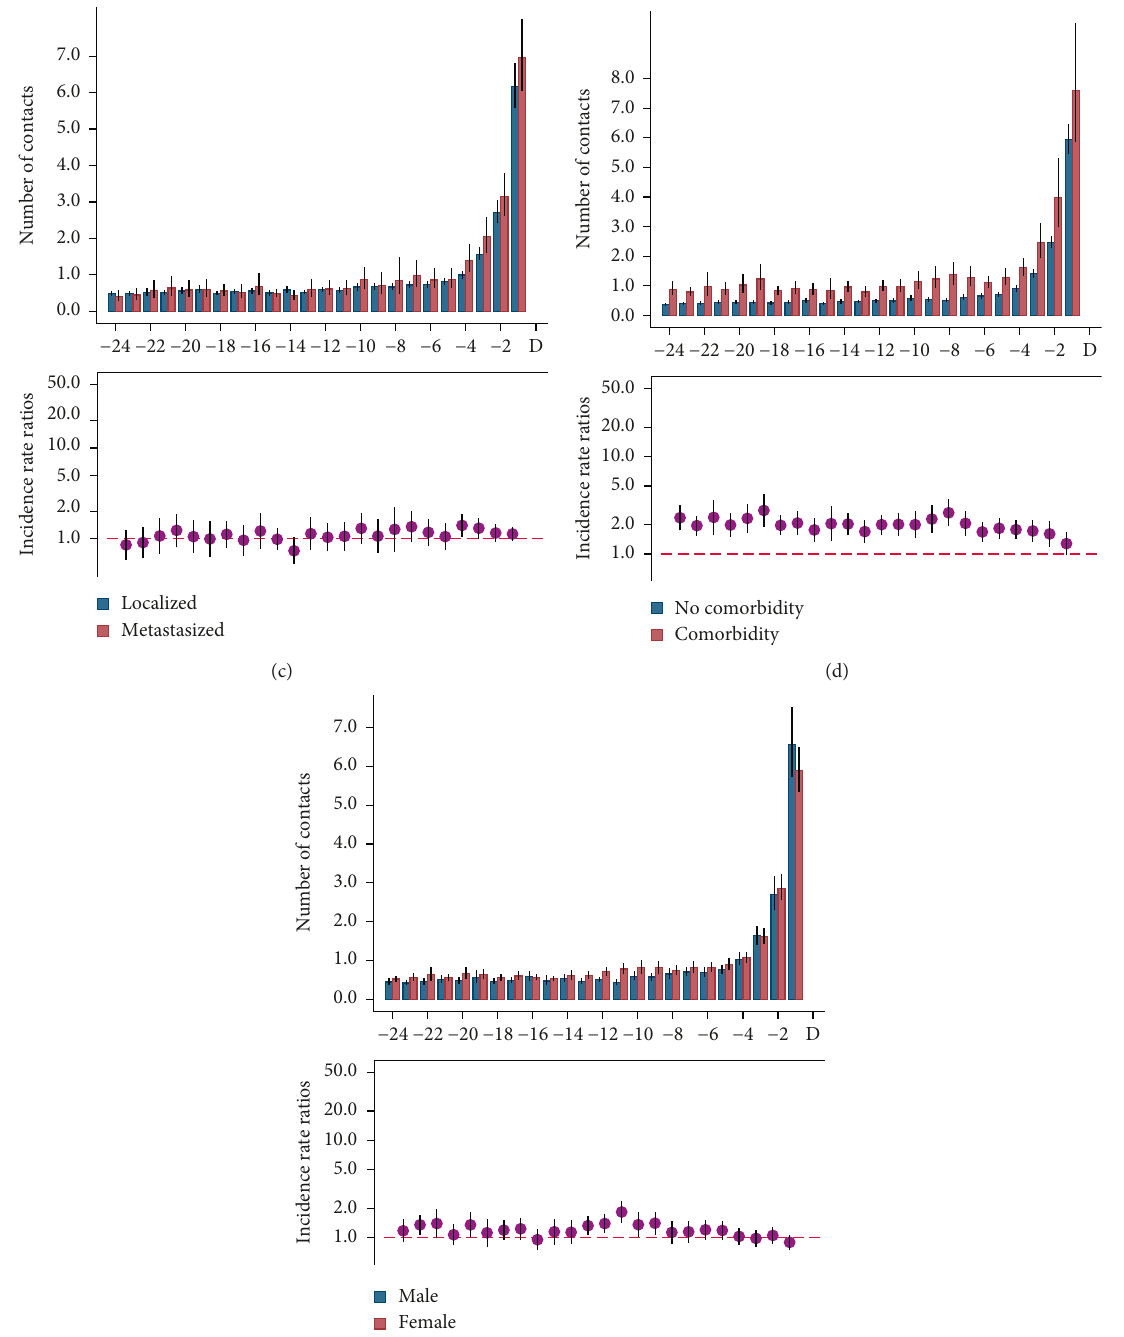
Figure 3: Monthly rates and incidence rate ratios (IRRs) for use of healthcare services in the case population in (a) sarcoma type, (b) tumour grade, (c) tumour stage, (d) comorbidity, and (e) gender for cases and references 24months before the sarcoma diagnosis, with 95% confidence interval (CI). Note the differences in the Y -axis